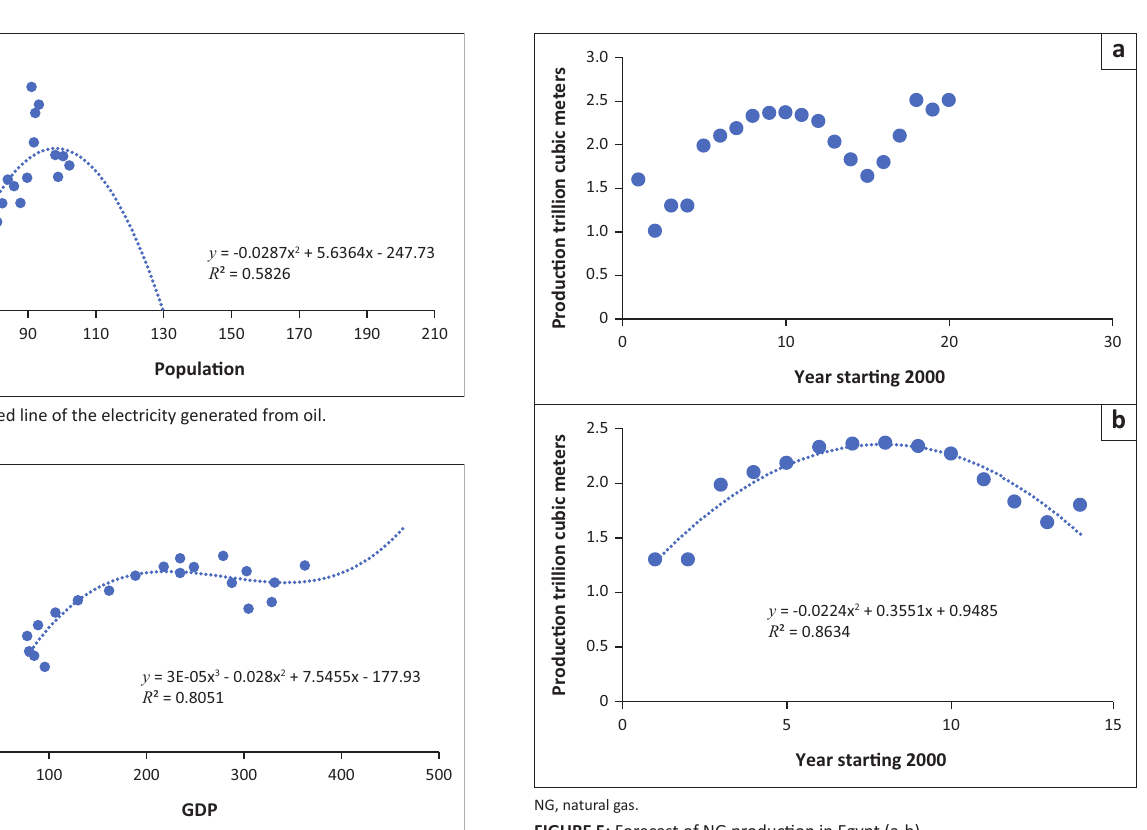
FIGURE 5: Forecast of NG production in Egypt (a-b).